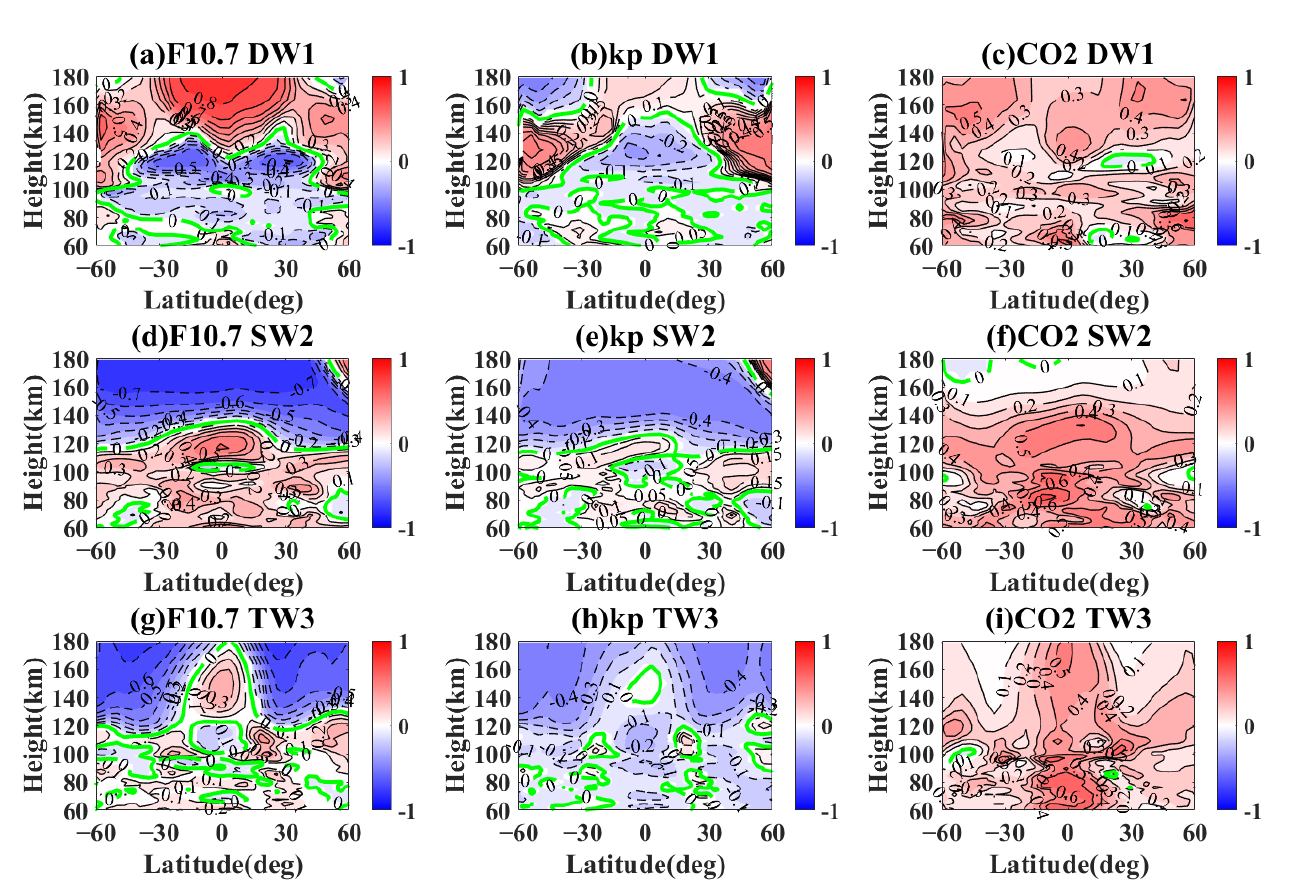
Figure 7. The correlation between migrating tidal variations ( a – c ) DW1, ( d – f ) SW2, and ( g – i ) TW3, and ( a , d , g ) F10.7 cm index, ( b , e , h ) kp index, and ( c , f , i ) CO 2 between 60 ° S and 60 ° N from 2003 to 2019. The green curve means the zero lines.